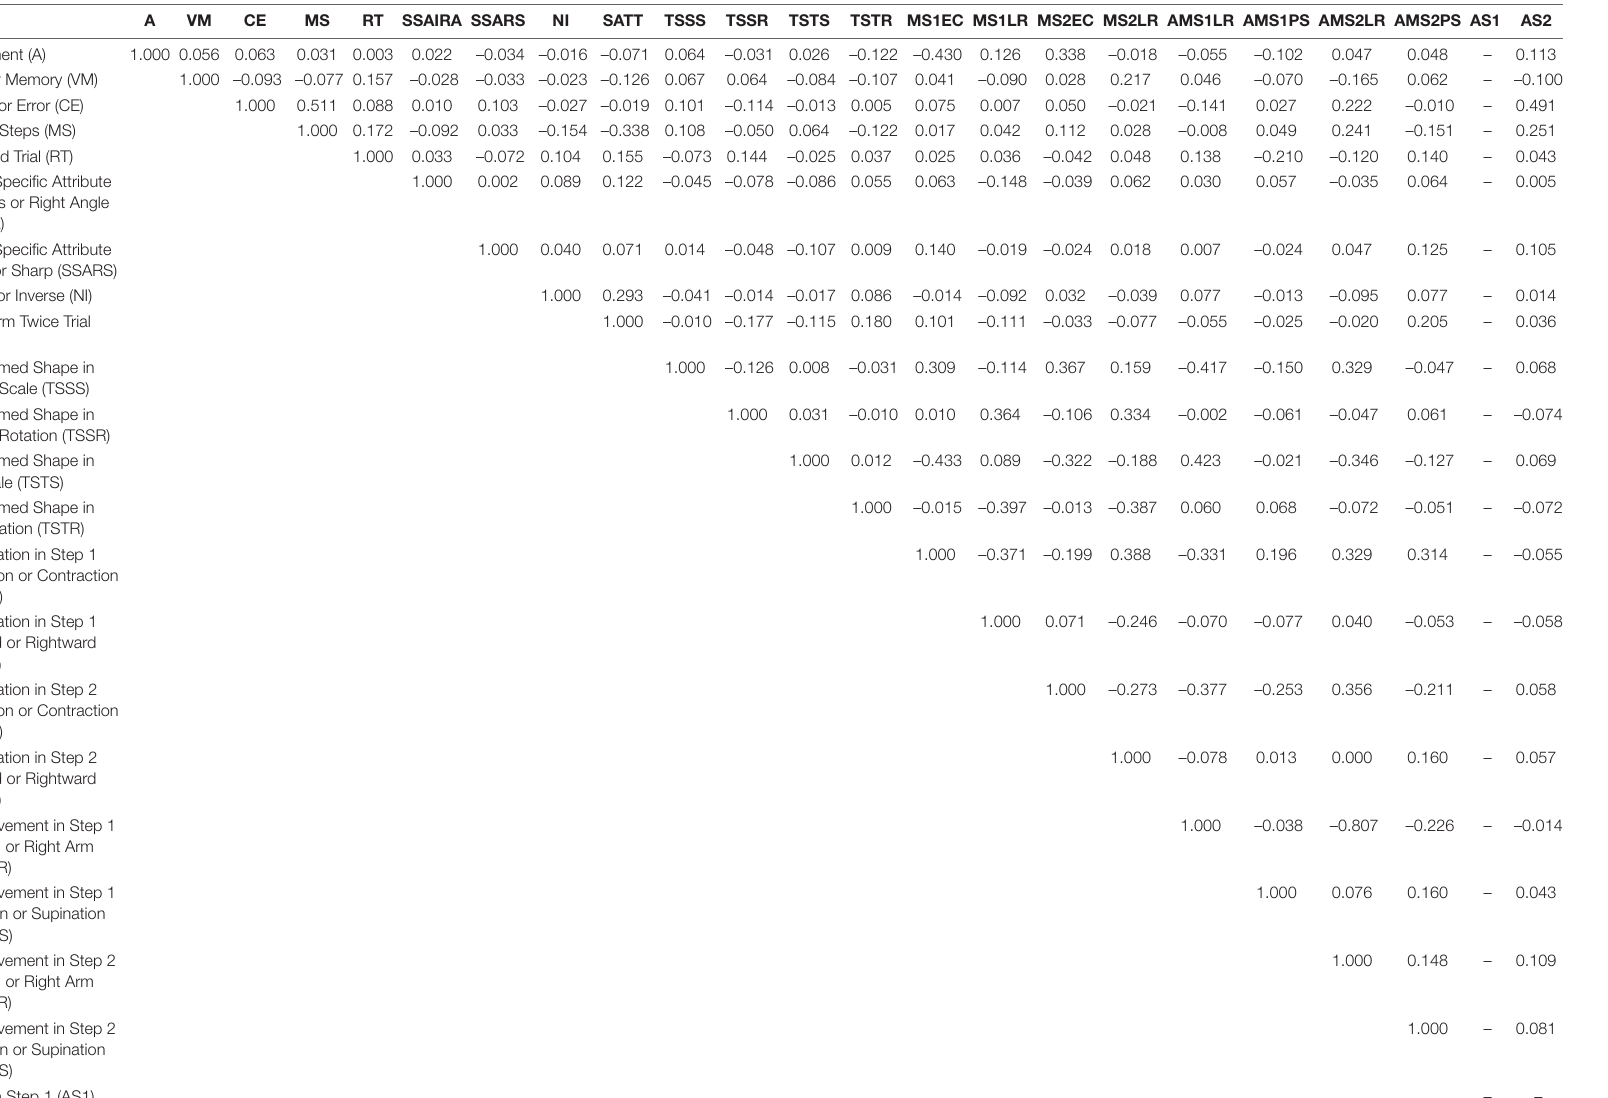
TABLE 1 | Correlations between predictor variables during the recording session of the example shown in Figure 3 left